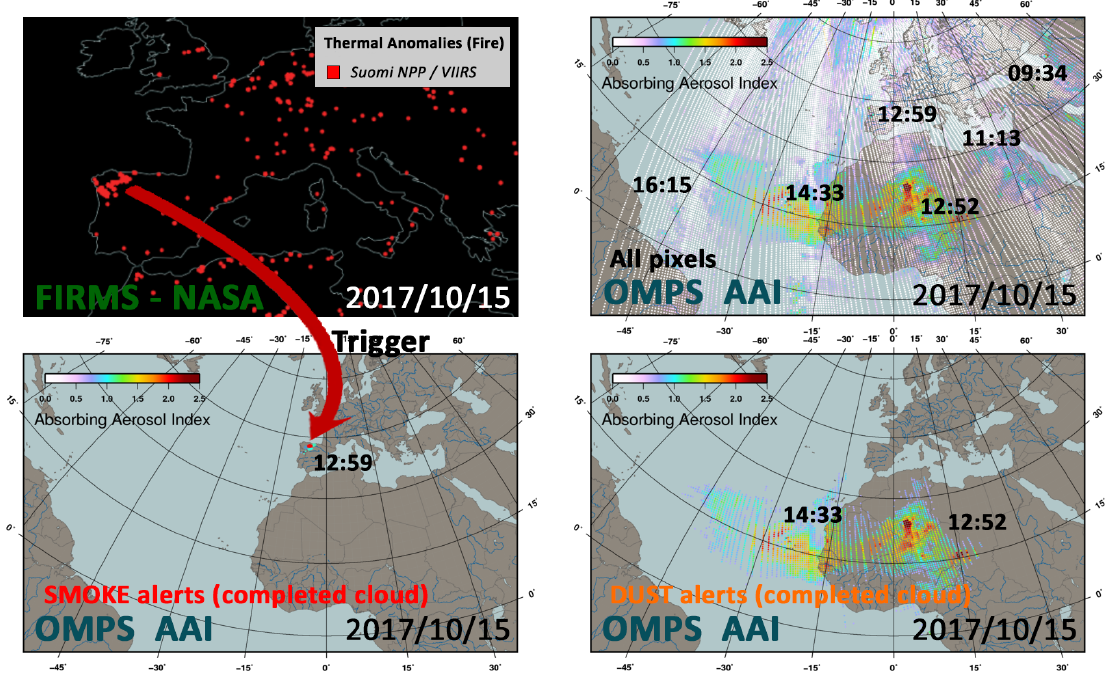
Figure 11. Illustration of the triggered approach to isolate OMPS AAI pixels related to smoke and dust (15 October 2017). Please note that the date format in this figure is